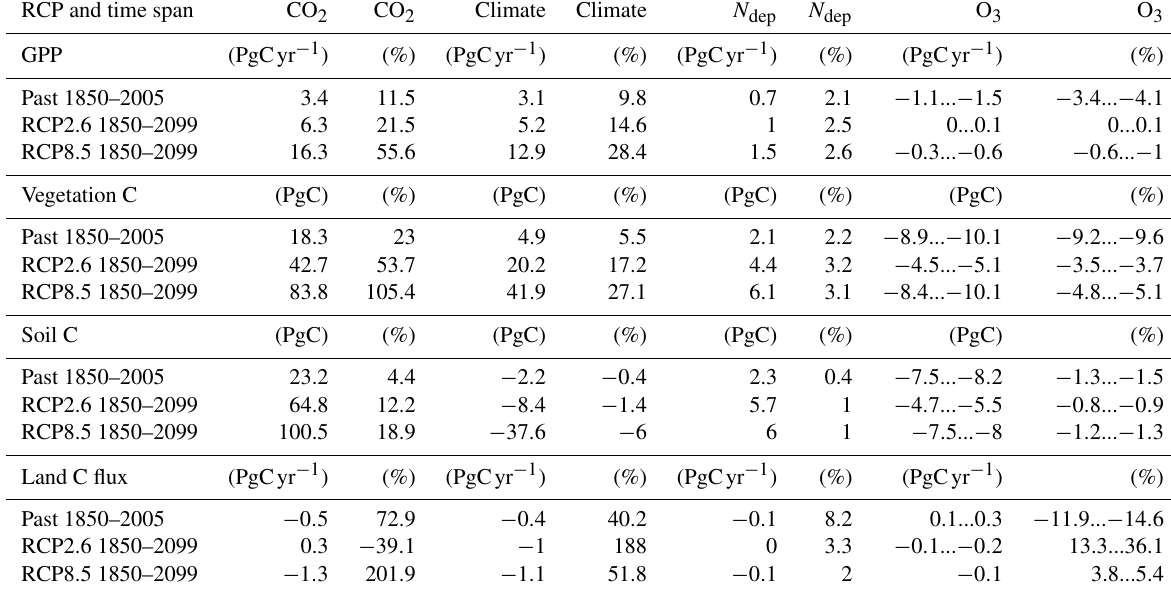
Table 3. Absolute and relative change in GPP, total carbon biomass in vegetation (vegetation C), soil organic matter carbon (soil C), and land carbon flux (land C flux) induced by changing atmospheric CO 2 concentrations, climate, nitrogen deposition ( N dep ), and O 3 concentra- tions. The differences in GPP, vegetation C, soil C, and land C flux are presented for simulations of the past years (1850 to 2005) and for the entire simulation period (1850 to 2099). The reported change refers to the change between the last and the first year of the respective time periods. The given range indicates the estimates according to both approaches for calculating the O 3 impact. RCP and time